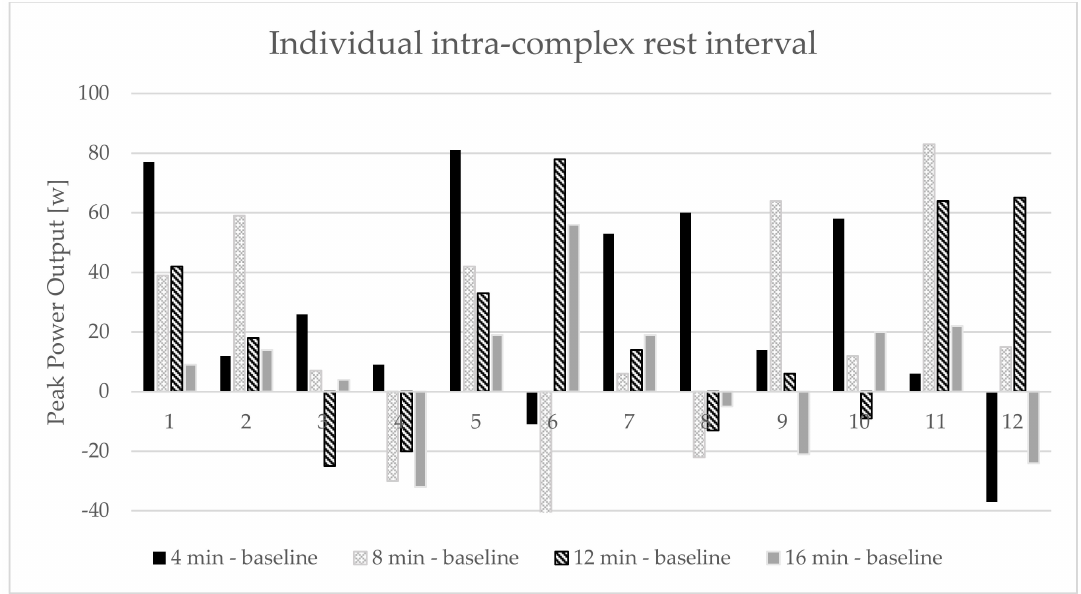
Figure 1. Individual di ff erences in peak power output between baseline and rest interval for each individual during the intra-complex rest interval test. The y-axis represents the di ff erence in peak power output between the baseline and rest interval for each